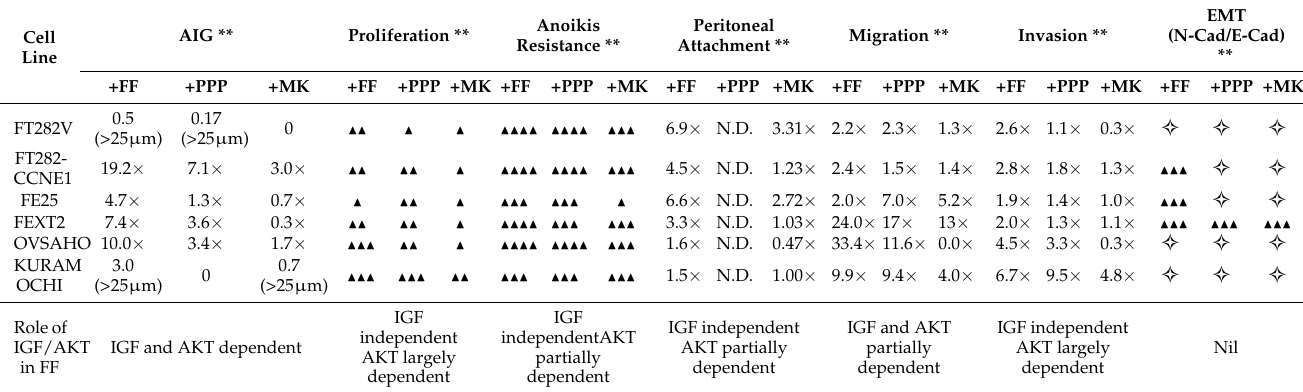
Table 3. Effect of FF and FF + kinase inhibitors in transformation phenotypes of FE and HGSC